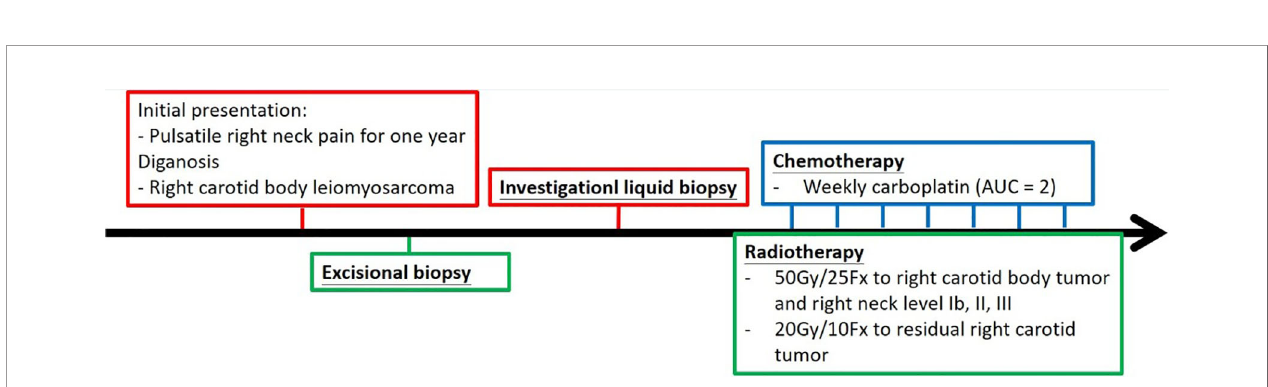
FIGURE 3 | Treatment course of this case was represented in a timeline. Weekly dose of carboplatin (area under curve 2) was administrated every week for 6 cycles, and conventional fractionated radiotherapy to carotid body and regional lymphatics was delivered concurrently with